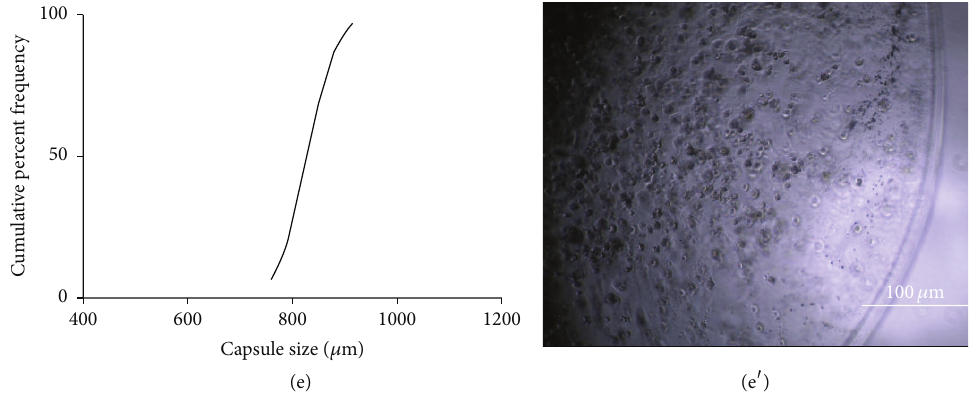
Figure 1: Cumulative size distribution (a–d) and microscopic images (a 󸀠 –d 󸀠 ) of Ca/Co alginate beads with encapsulated hADSCs at 2 h after preparation. ((a), (a 󸀠 )) Control sample; ((b), (b 󸀠 )) Co1.25 sample; ((c), (c 󸀠 )) Co2.5 sample; ((d), (d 󸀠 )) Co5 sample; and ((e), (e 󸀠 )) Co10 sample. The mean bead diameters were as follows: control, 810 ± 36 𝜇 m; Co1.25, 821 ± 98 ; Co2.5, 789 ± 52 ; Co5, 826 ± 74 𝜇 m; and Co10, 804 ± 16 𝜇 m.